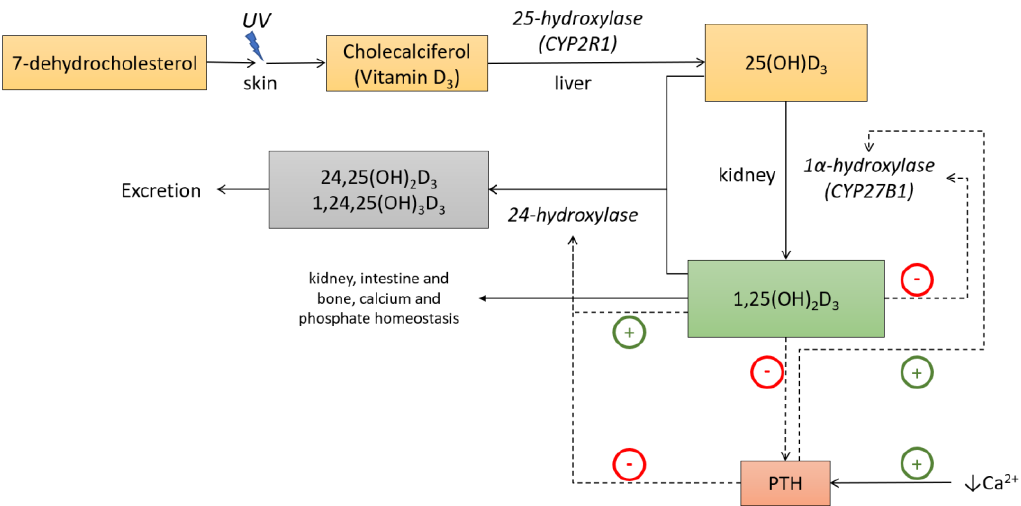
Figure 1. Vitamin D metabolism and functions. Under ultraviolet B light (UVB) exposure, 7-dehydroxycholesterol is converted to vitamin D 3 in the skin. First, hydroxylation occurs in the liver where it is converted to 25-hydroxyvitamin D 3 . 25-hydroxyvitamin D 3 is further converted in the kidney to its active metabolite, 1 α ,25-dihydroxyvitamin D 3 . In the kidney, 1 α -hydroxylase is stimulated by the parathyroid hormone (PTH) and feedback inhibited by 1 α ,25-dihydroxyvitamin D 3 . 1 α ,25-dihydroxyvitamin D 3 targets the intestine, kidney and bone to regulate calcium and phosphate homeostasis. Adapted from Lim et al [6] .